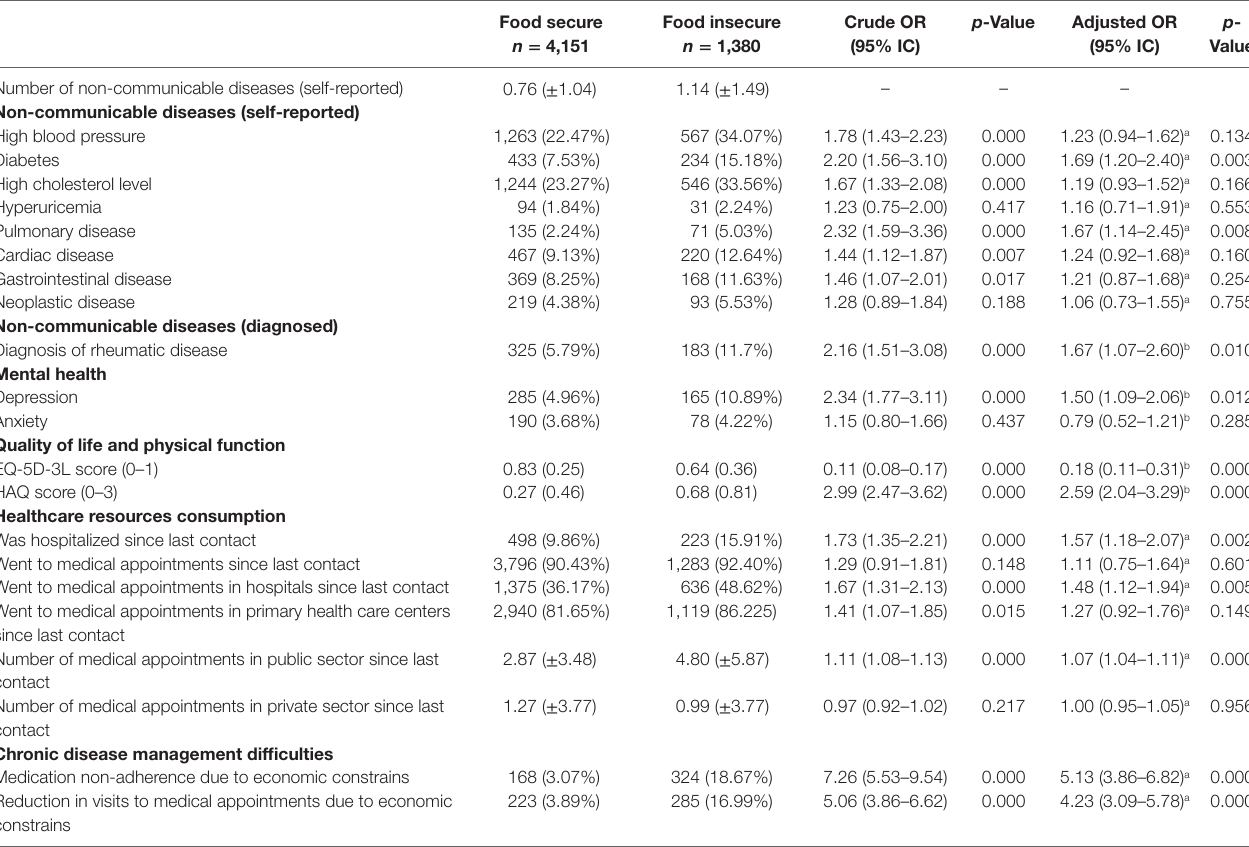
TaBle 3 | Comparison of health status and healthcare resources consumption between households with and without food